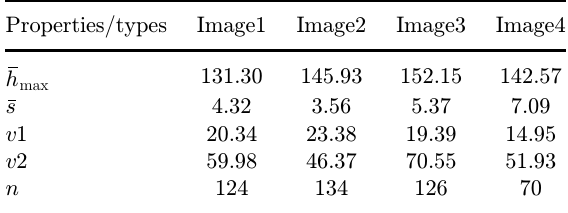
Table 2. ICT features of basophil vs lymphocyte. Properties/types